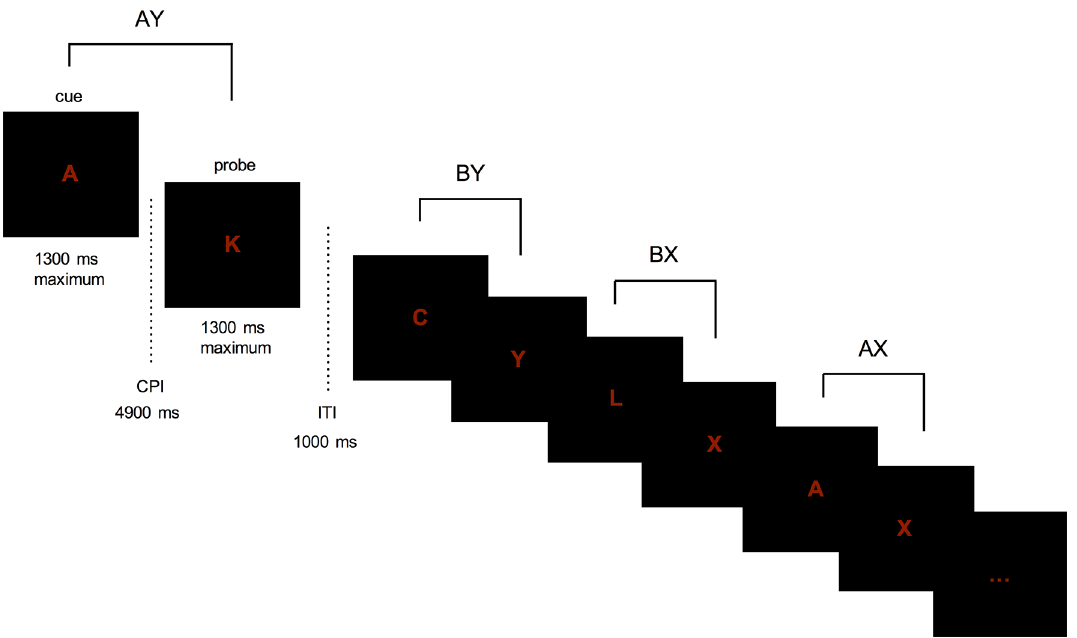
Figure 3. Trial sequence of the AX-CPT